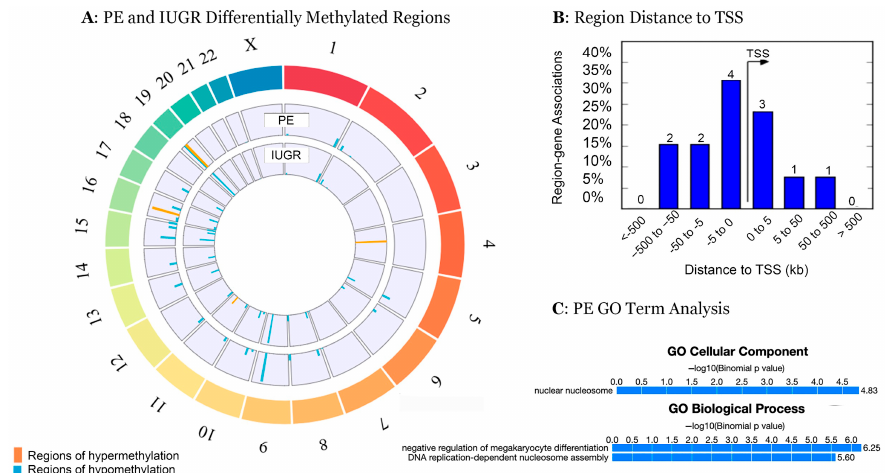
Figure 2. Comparative methylation profiles and ontological analysis of placental tissues. Circos Plot indicating regions of significant hyper and hypomethylation (FDR > 13) across the genome in PE (outer ring) and IUGR (inner ring) ( A ). Height of region indicates the size of variance from control (log2ratio). Distance of each region from transcription start site of the most differentially methylated regions (FDR > 40) ( B ). GO term analysis of the most differentially methylated regions for PE ( C ). Table 2. Hypomethylated regions with FDR scores ≥ 40.